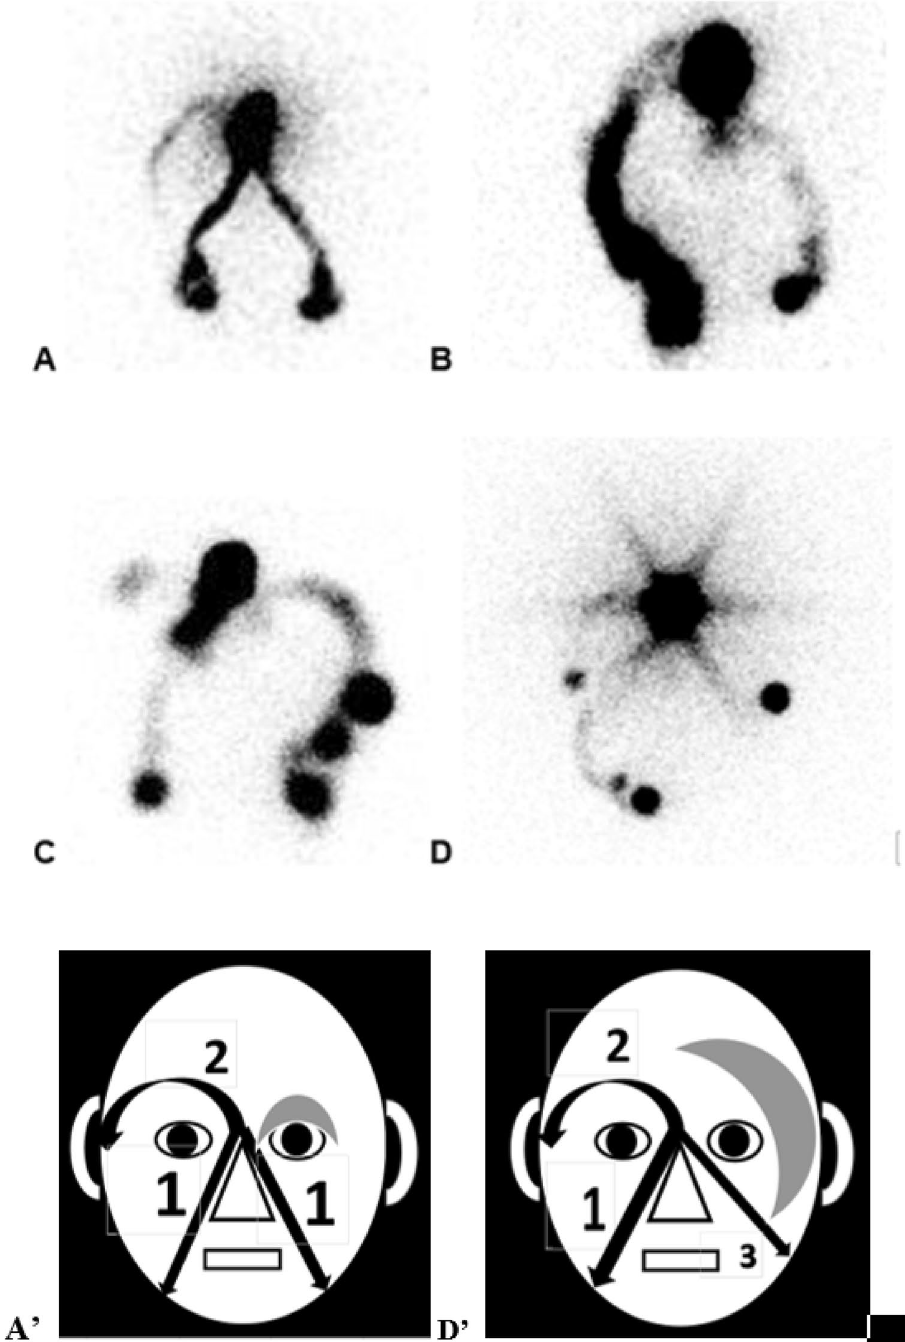
Figure 4. Picture ( A ) (scintigraphic view) and ( D’ ) (schematic presentation of the result): in this case referred for isolated edema at the level of the left eyelid (gray zone), the paranasal lymphatic drainages appear normally (arrows 1) while the appearance of the supra-ocular LV is delayed (arrow 2) and while the left supra-ocular lymphatic drainage could not be demonstrated. The 1ary origin of this abnormality was suggested by the demonstration of one associated malformation of the ductus thoracicus by a bipedal lymphoscintigraphy. Picture ( B ) In this case, the patient had injections of Botulinum Toxine at the level of her face. She complained of edema at the level of the eyelids but more pronounced on the left in the upper part and on the right in the external part. In her case, only the right supra ocular and left para nasal drainages could be demonstrated. Picture ( C ) In this patient who was referred with edema at the level of the two eyelids but more pronounced at the inferior part of the right one and who had presented right otitis, the left paranasal lymphatic drainage is not seen, the right supra ocular is not complete and the right para nasal drainage is unusually hyperactive in its upper and apical part. Picture ( D ) (scintigraphic view) and ( D’ ) (schematic presentation of the result): this patient had congenital micro-cystic lymphangiomatous lesions at the level of her left edematous hemiface (gray zone). The exam showed normal right para nasal lymphatic drainage (arrow 1) and delayed supra-ocular lymphatic drainage (arrow 2) but no supra ocular on the left side and one abnormal left infra ocular drainage reaching intra-parotid LN (arrow